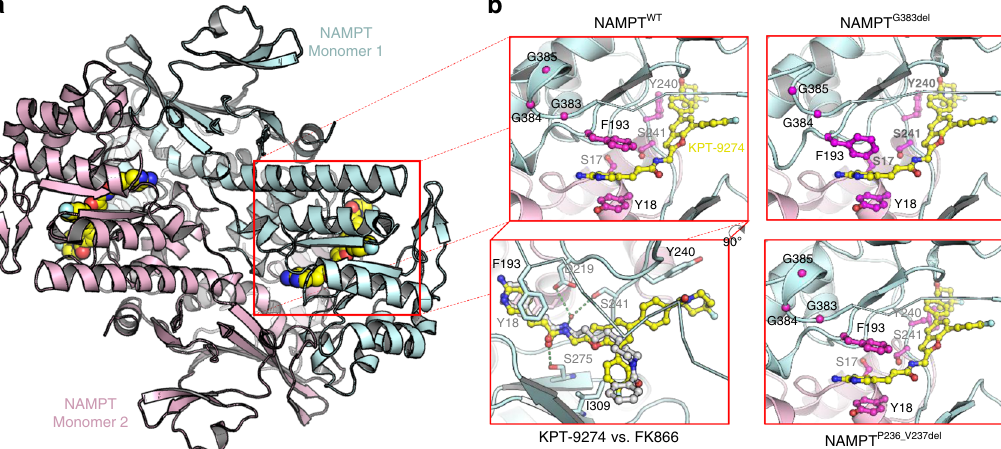
Fig. 4 Co-crystal structure of NAMPT dimer with KPT-9274. a The crystal structure of NAMPT dimer with KPT-9274 is depicted as a cartoon with the NAMPT monomers shown in light blue and pink and KPT-9274 as yellow spheres. b A sideways blow-up (top left) shows the drug-binding site with KPT- 9274 depicted in yellow carbons. A second blow-up (down left) shows the overlap between KPT-9274 and FK866. The pi stacking of KPT-9274 between the Y18 and F193 matches the binding mode of FK866 and important hydrogen bonds, depicted as green dashed lines (between S275 and protein-bound water coordinated by D219 and S241), overlap between the two compounds. The right panels show the in fl uence of the G383del (top) and P236_V237del (bottom) resistance